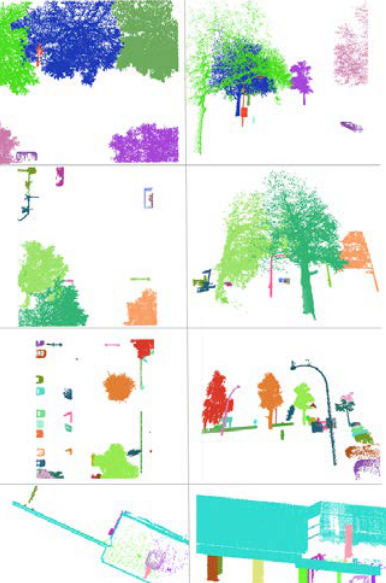
Figure 6 Top view (left) and street or oblique view (right) of above ground object components.